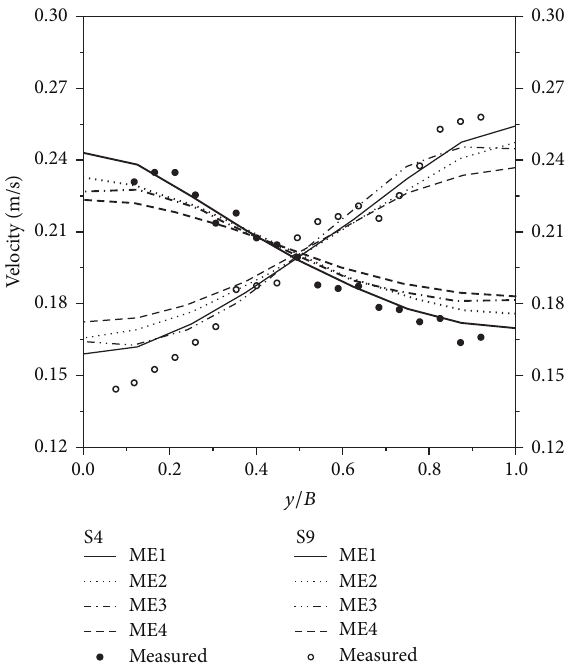
Figure 2: Velocity distributions of the meandering channel flow according to varying eddy viscosities.